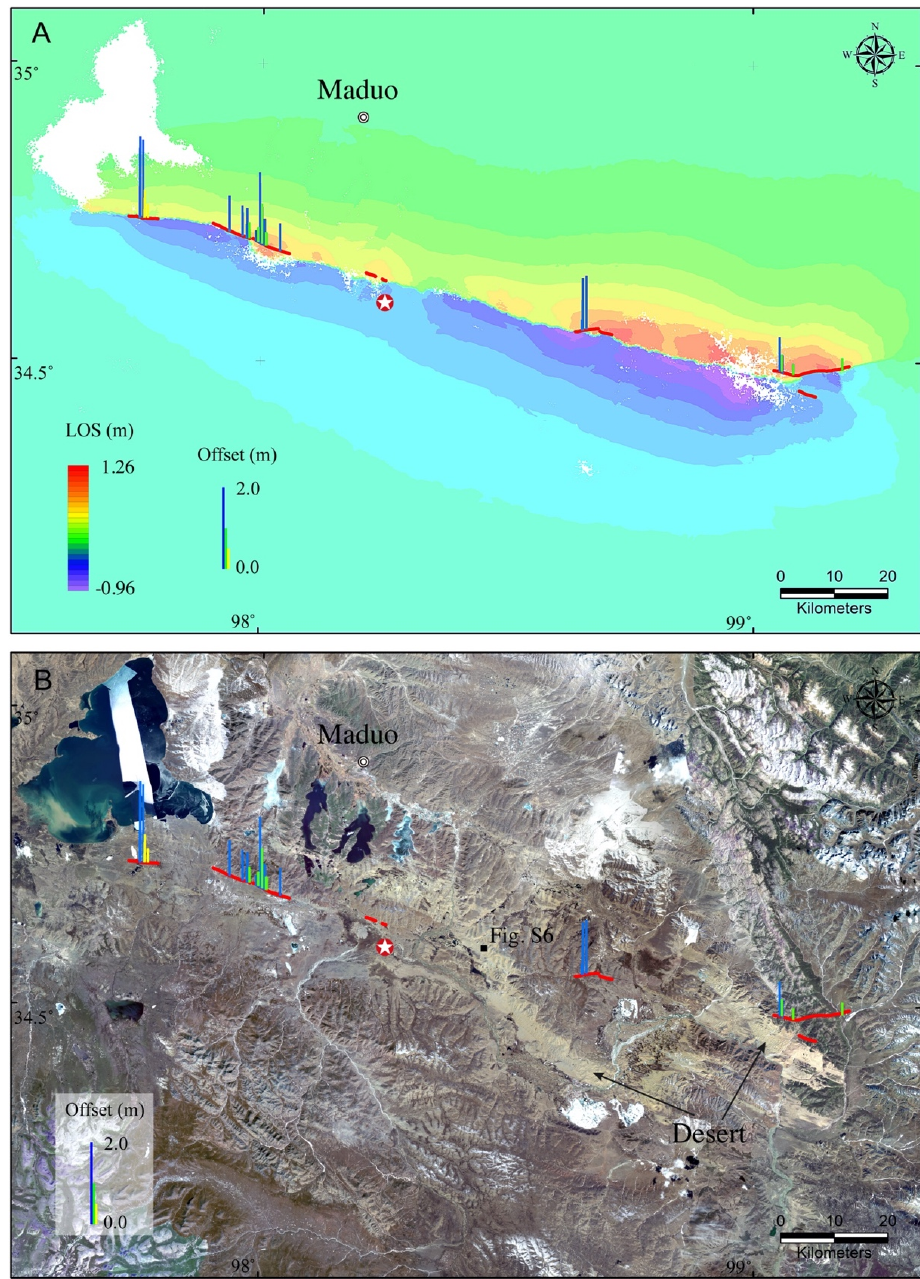
Figure 10. Offsets and main continuous surface fracture projected onto the ( A ) D-InSAR result and ( B ) satellite image. The blue bar represents the horizontal displacement. Green and yellow bars represent the vertical displacement, yellow represents the uplift of the south wall, and green represents the uplift of the north wall. The red lines indicate continuous surface fracture and deserts are distributed in the large surface rupture